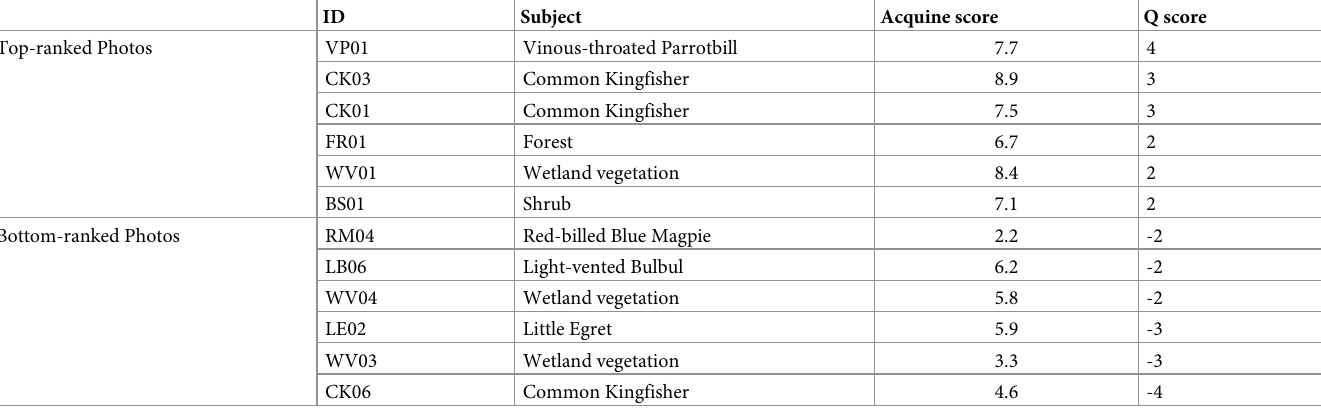
Table 5. The six top-ranked photographs (a) and the six bottom-ranked photographs (b) for Factor 3. ID Top-ranked Photos